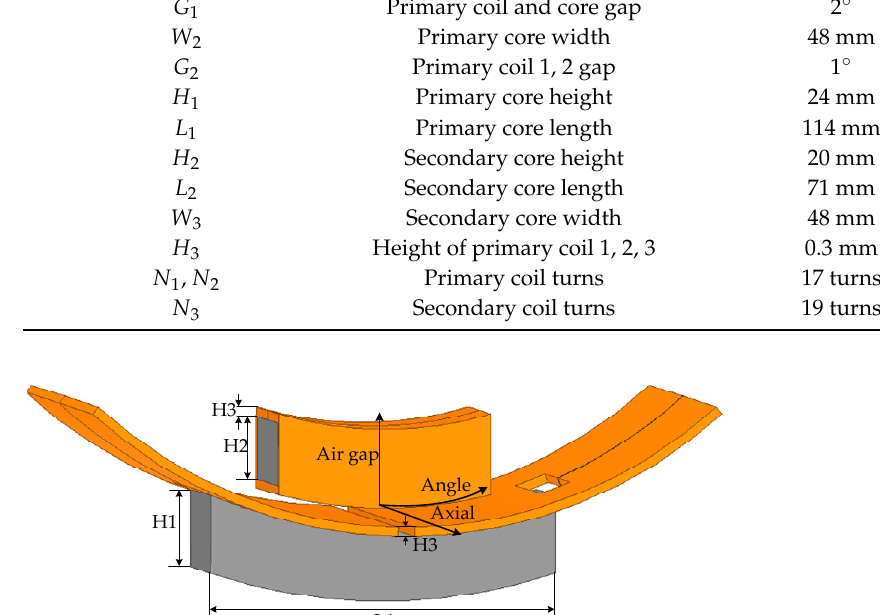
Figure 4. Schematic diagram of misalignment. Table 1. Parameters of the MC.